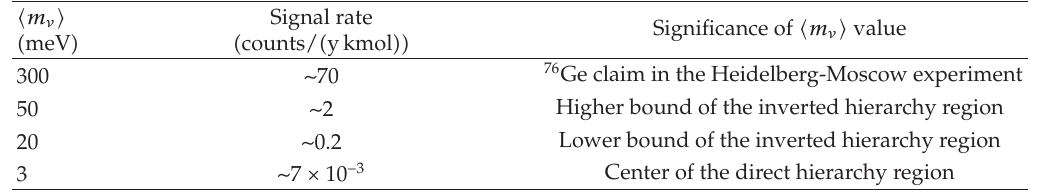
Table 3: Signal rates for an “average” double-beta decay